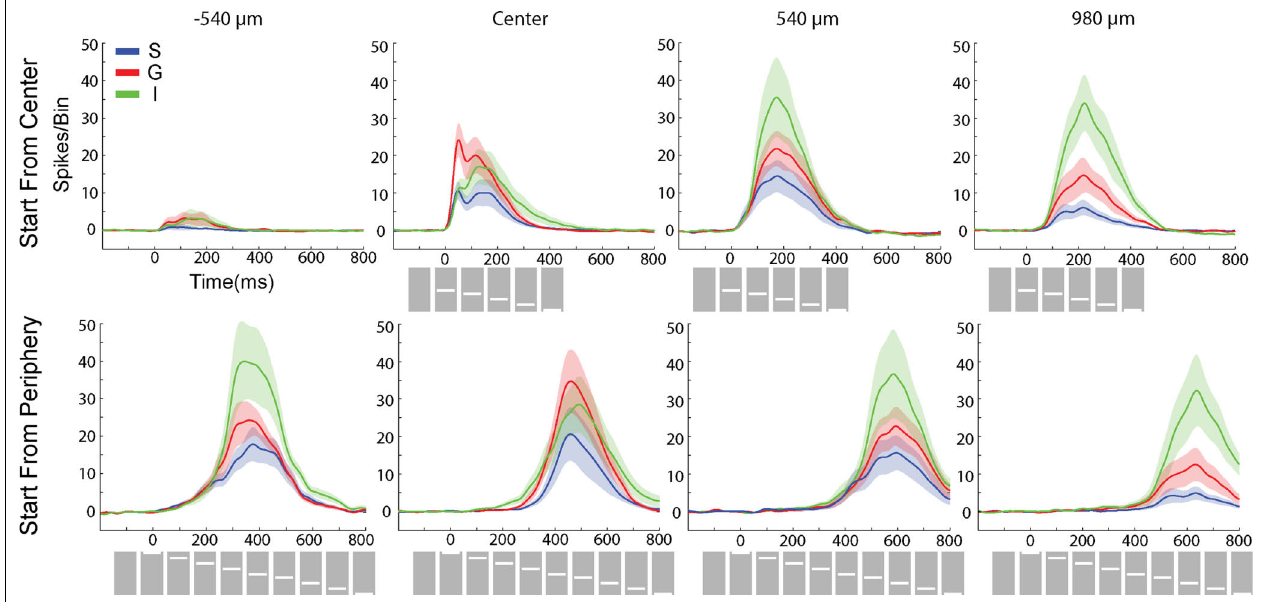
FIGURE 4 | Average laminar MUA rates ( N = 11) to the bar moving from the CFOV (Top) and the bar moving from peripheral FOV (bottom). Electrode penetrations at − 540 µm (i.e. in the direction opposite to motion for bar motion beginning at the CFOV, and prior to entering the CFOV for bar motion originating in the peripheral FOV; at the retinotopic point of CFOV (center); and at 540 µm